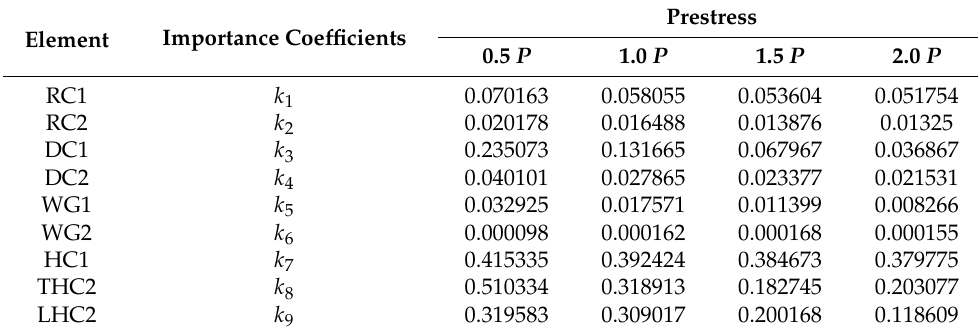
Table 2. Importance coefficients of the elements under different initial prestress levels. Element